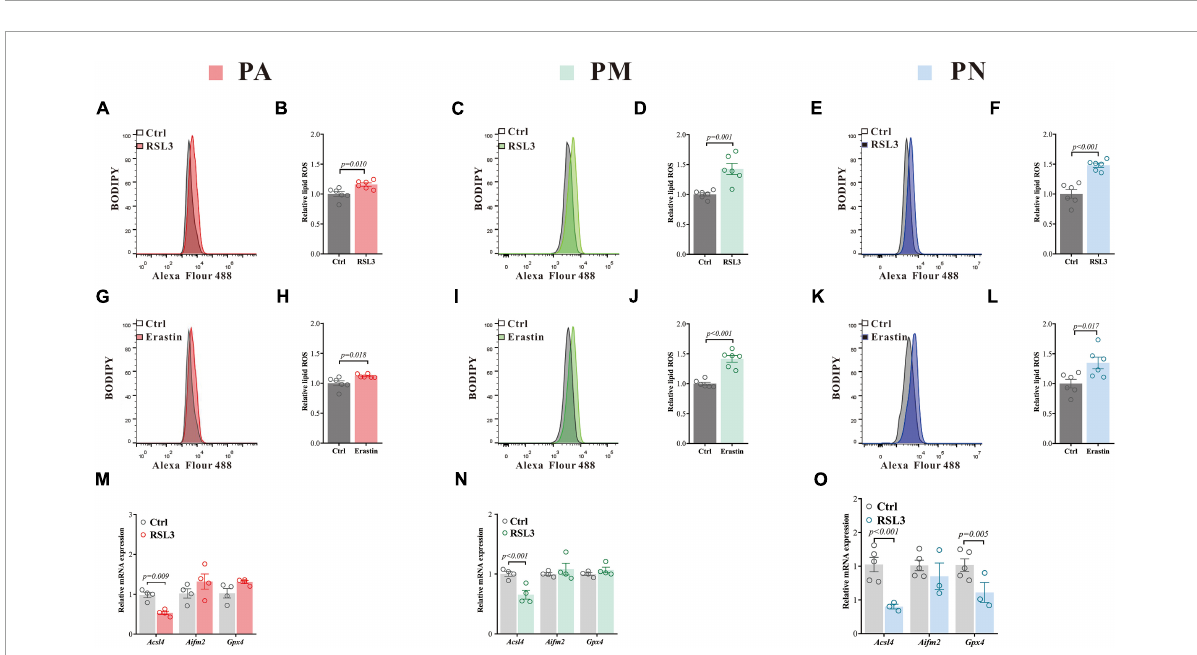
FIGURE2 Ferroptosis inducers lead to increased ROS and changes in ferroptosis-related gene expressions in primary brain cells. (A–F) Lipid ROS in PA (A) , PM (C) and PN (E) treated with RSL3 for 24 h (representative histogram plot for fluorescence of oxidized BODIPY-C11), respectively. Relative lipid ROS is presented as the ratio of oxidized to reduce BODIPY-C11 MFI in PA (B) , PM (D) and PN (F) treated with RSL3 for 24 h, respectively N = 6. (G–L) Lipid ROS in PA (G) , PM (I) and PN (K) treated with erastin for 24 h (representative histogram plot for fluorescence of oxidized BODIPY-C11), respectively. Relative lipid ROS is presented as the ratio of oxidized to reduce BODIPY-C11 MFI in PA (H) , PM (J) and PN (L) treated with erastin for 24 h, respectively N = 6. (M,N) qPCR was performed to quantify the mRNA levels of ferroptosis-related genes in PA (M) , PM (N) and PN (O) after 24 h of RSL3 treatment, respectively. Data are means ± SEM, N = 3–5. Student’s t -test was